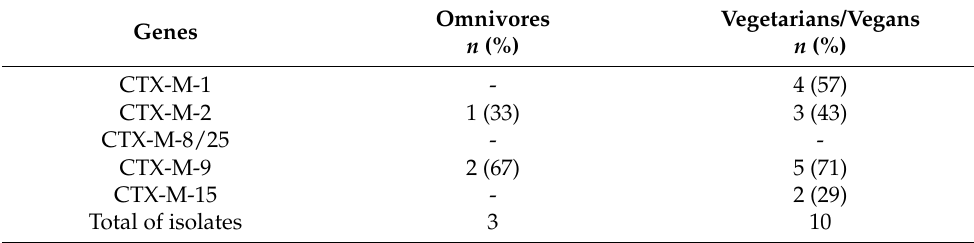
Table 5. Prevalence of CTX-M ESBLs among E. coli isolated from omnivores and vegetarians/vegans.